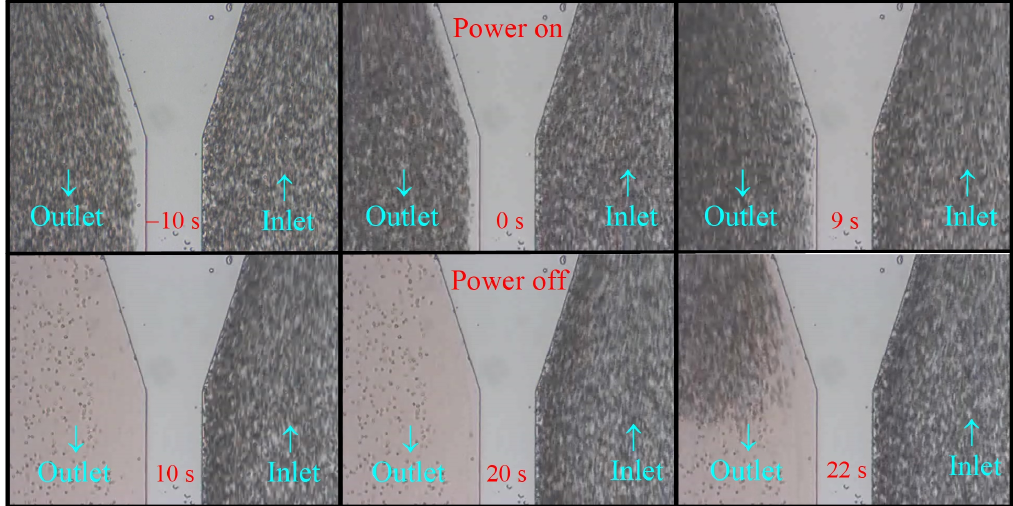
Figure 4. Snapshots at different time instants from Video S2 for case T2 in Table 1 (2 V 0 = 20 V pp , a = 50 µ m, Q = 100 µ L / hr, tapered inlet / outlet). No moving cells were observed (completely lysed) in the outlet region from 10 s to 20 s after the power of the electrodes had been turned on for 10 s.